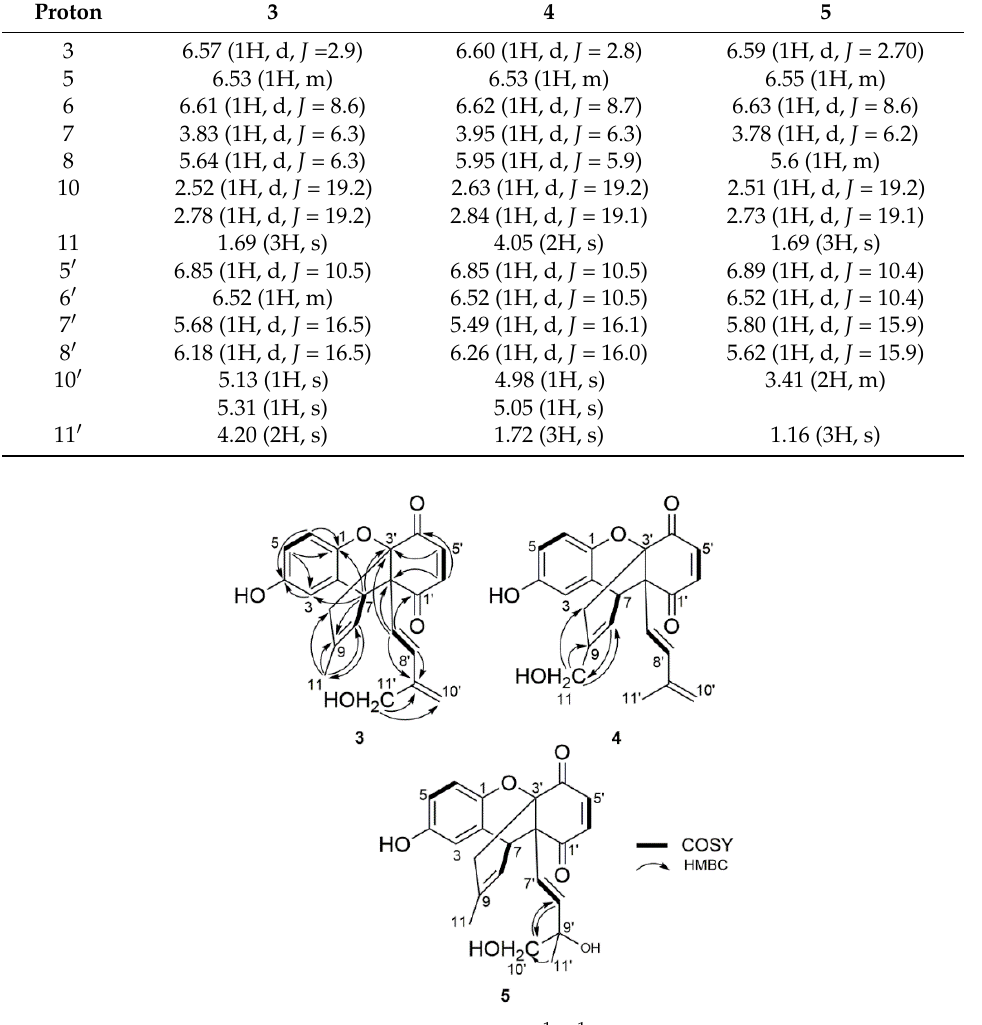
Figure 2. Gross structure of ehretiquinones B–D ( 3 – 5 ) with 1 H- 1 H COSY and selected HMBC correlations.